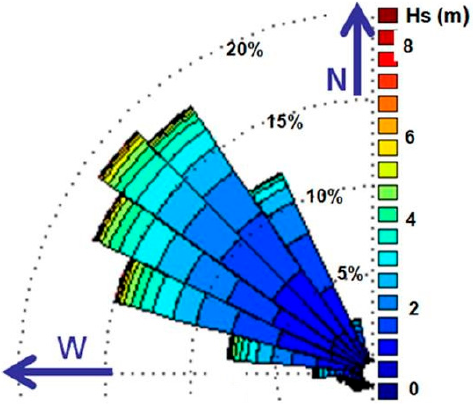
Figure 2. The classes of significant wave height corresponding to each directional bin of 10 ◦ , as provided by the buoy measurements, corresponding to the ten-year time interval (1994–2003), are represented.